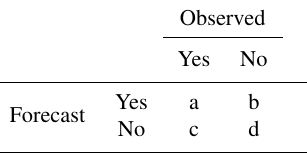
Table 2. Contingency table to support Eqs. (2) and (3).